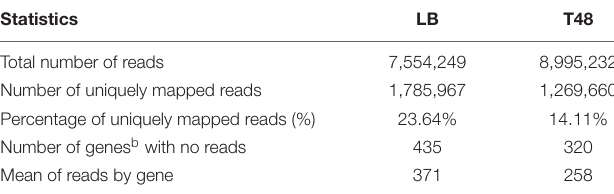
TABLE 2 | Summary of Tn-seq coverage